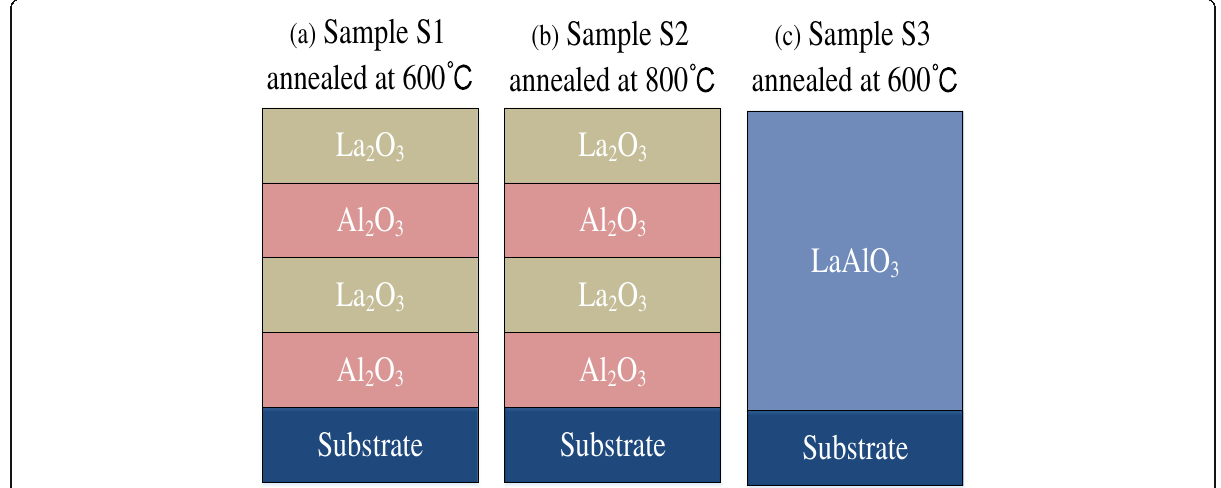
Fig. 1 Schematic structures of multilayer La 2 O 3 /Al 2 O 3 stack samples S1 and S2 and LaAlO 3 sample